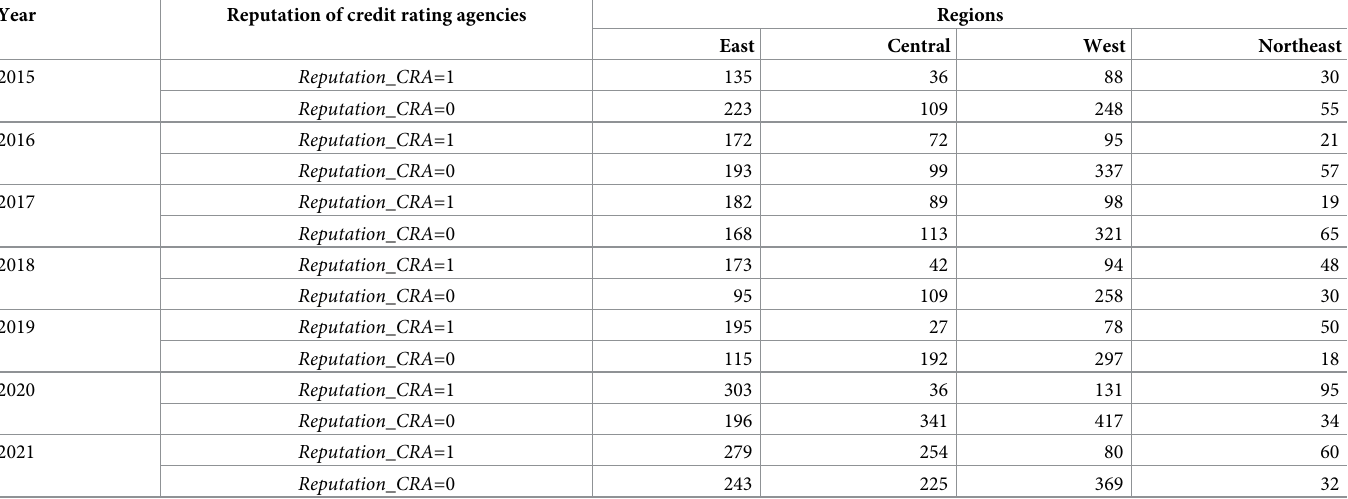
Table 7. Number of bonds rated by the credit rating agencies with high or low reputation in each region each